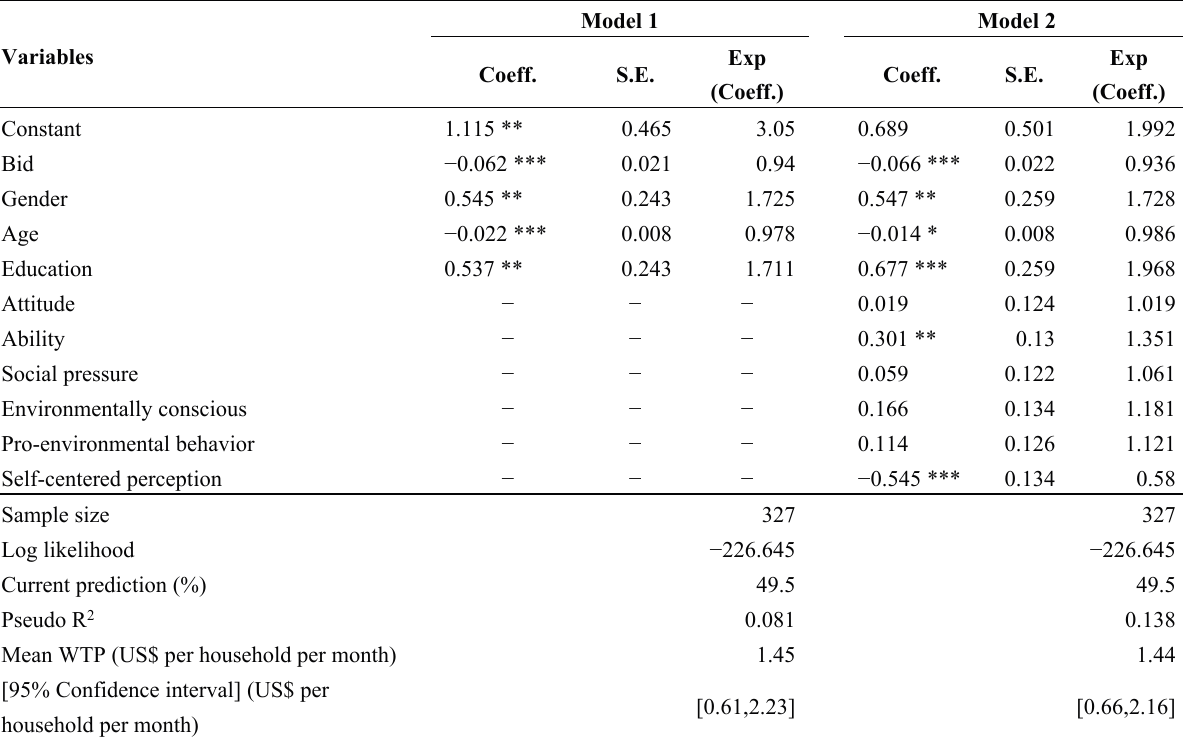
Table 7. Results of logistic regression analysis of factors affecting WTP for household kitchen waste separation services (n =